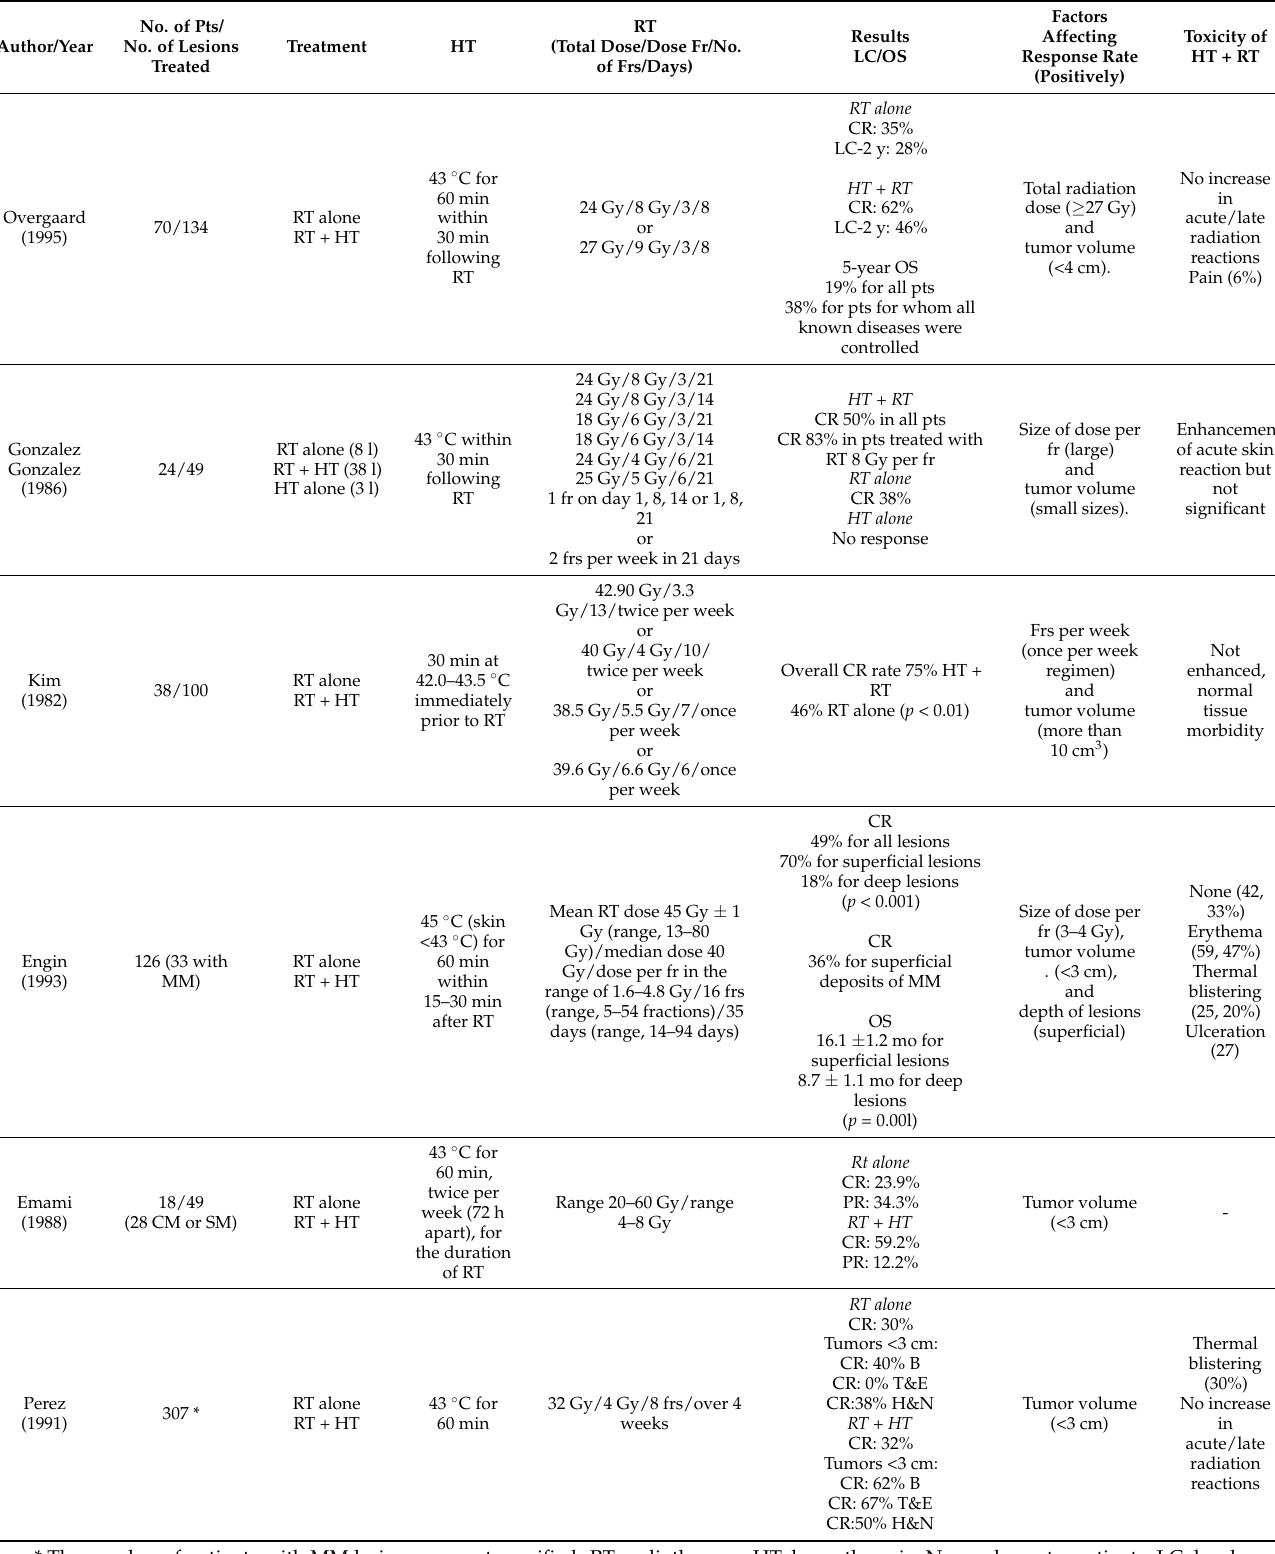
Table 1. Studies of radiotherapy in combination with hyperthermia in melanoma lesion